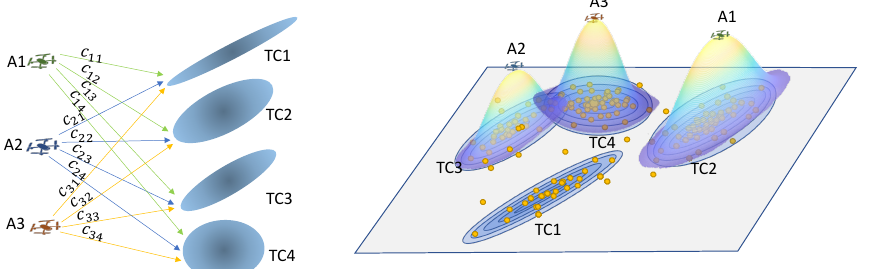
Figure 1. An optimal service-matching UAV deployment via AP formulation. c i , j indicates the level of similarity between agent A i ’s service distribution with the target cluster TC j ’s distribution. The figure depicts a case that agent A1, A3, and A3 are assigned, respectively, to TC2, TC3 and